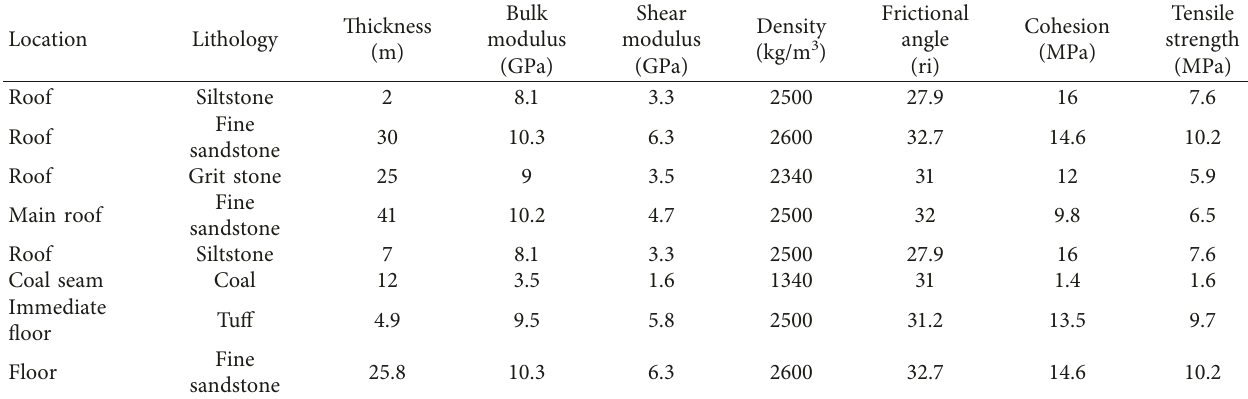
Table 2: Strata material